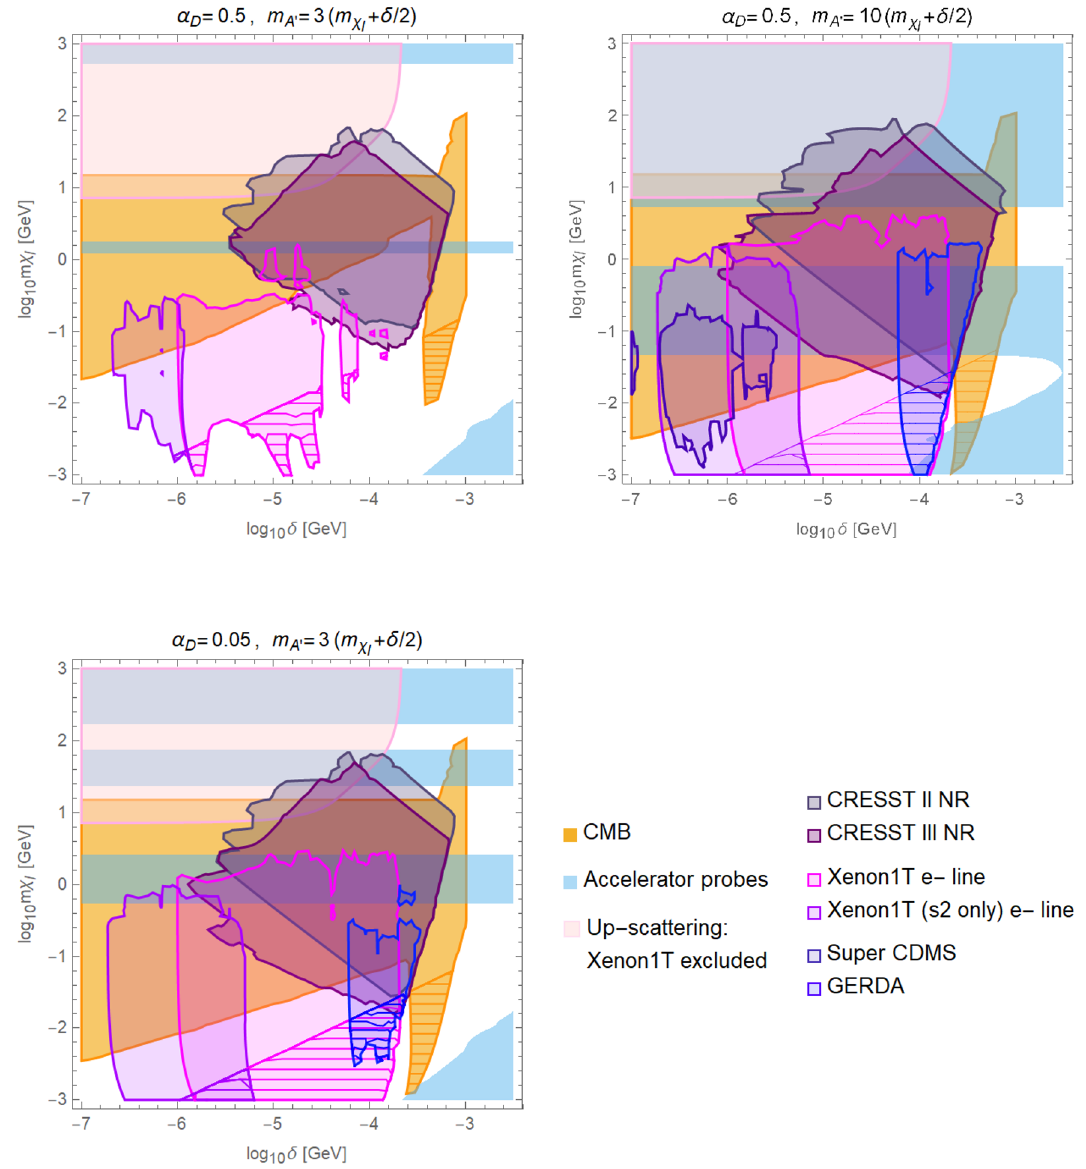
Figure 23 . Detailed exclusion regions for direct detection probes, as in figure 9 but for different values of α and m . We also show the constraints from collider probes in light blue and D χ /m A 0 CMB in mustard. Here, we can clearly see that small α the striated areas, semi-elastic interactions can further deplete the χ